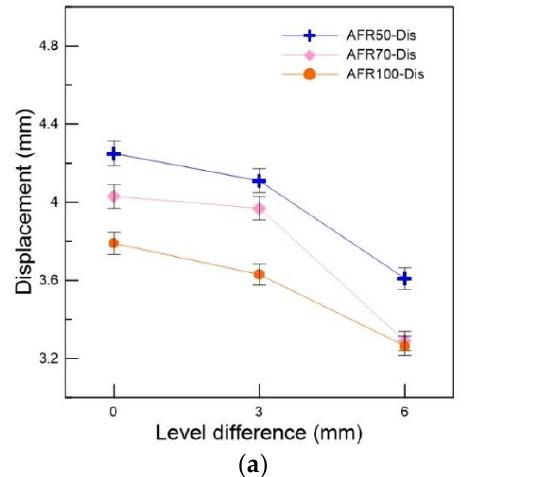
Figure 10. Variation in the ( a ) maximum displacement and ( b ) maximum load of tensile specimens with varying adhesive filling rations in relation to the level difference.